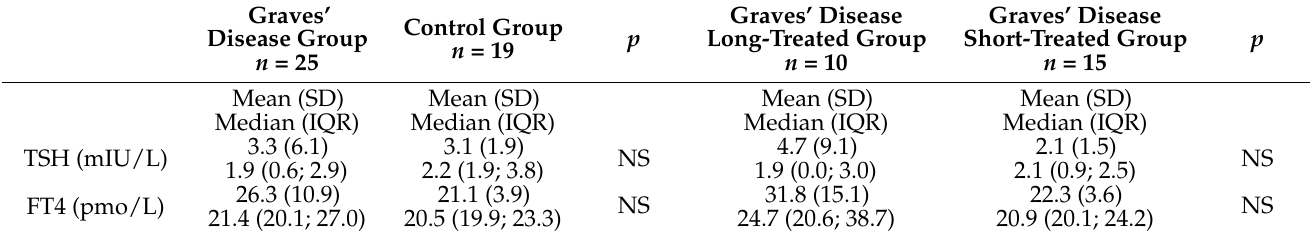
Table 4. Concentrations of FT4 and TSH in neonates assessed between 4 and 7 days of life; comparison between the